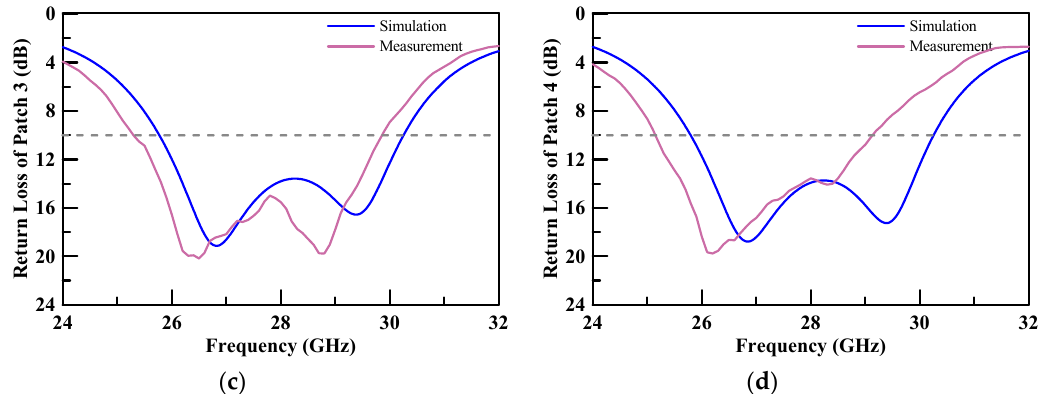
Figure 15. Comparison of the simulation and empirical results of the return loss of each patch, ( a ) return loss of Patch1; ( b ) return loss of Patch2; ( c ) return loss of Patch3; ( d ) return loss of Patch4.